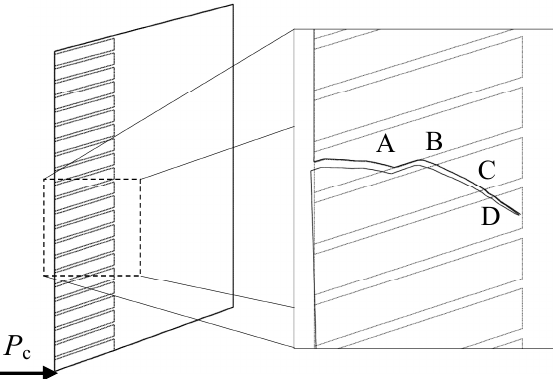
Figure 7. Fracture of a cutter with a cellular microstructure: scheme of the compact bit ( left ) and magnification of the crack path in the region inside the rectangular dashed box ( right